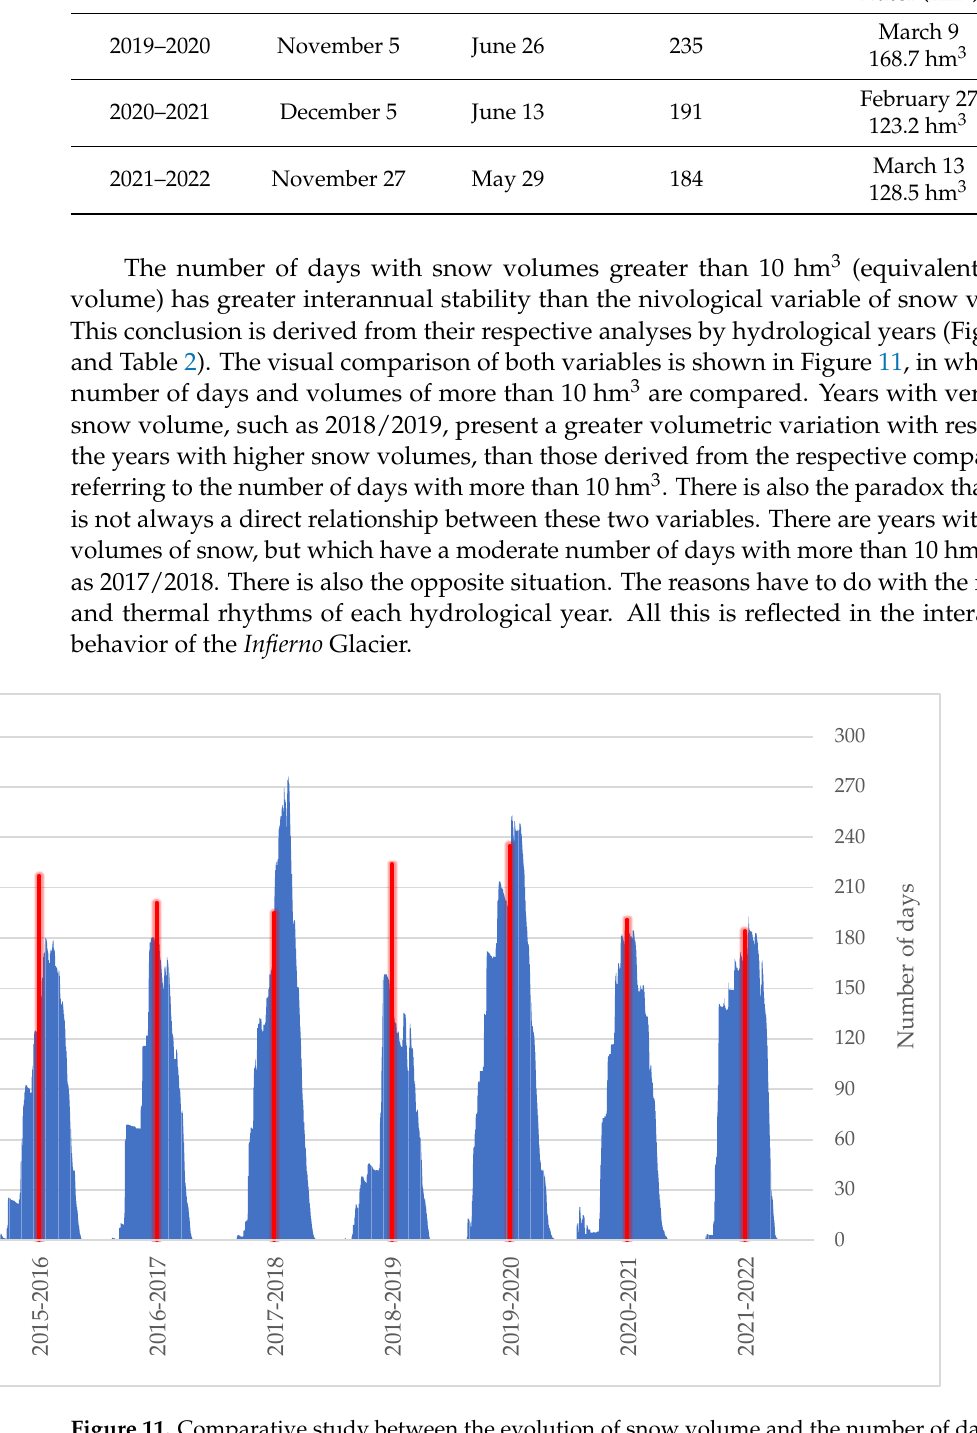
Figure 11. Comparative study between the evolution of snow volume and the number of days with snow volume higher than 10 hm 3 , in the upper G á llego River basin (up to the B ú bal Reservoir), by hydrological years. 2015/2016 to 2021/2022. Base data: daily snow volumes, expressed in hm 3 (equivalent water volume). Blue: snow volume; red: number of days. Data source and methodology: CHE-SAIH